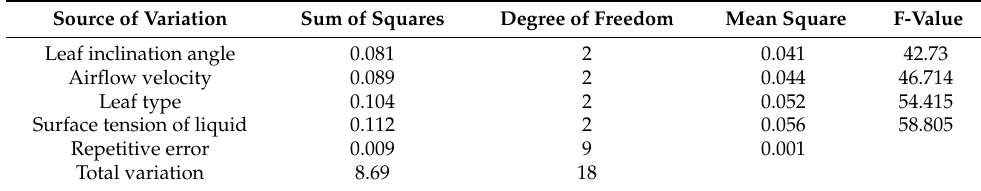
Table 11. Analysis of variance for orthogonal